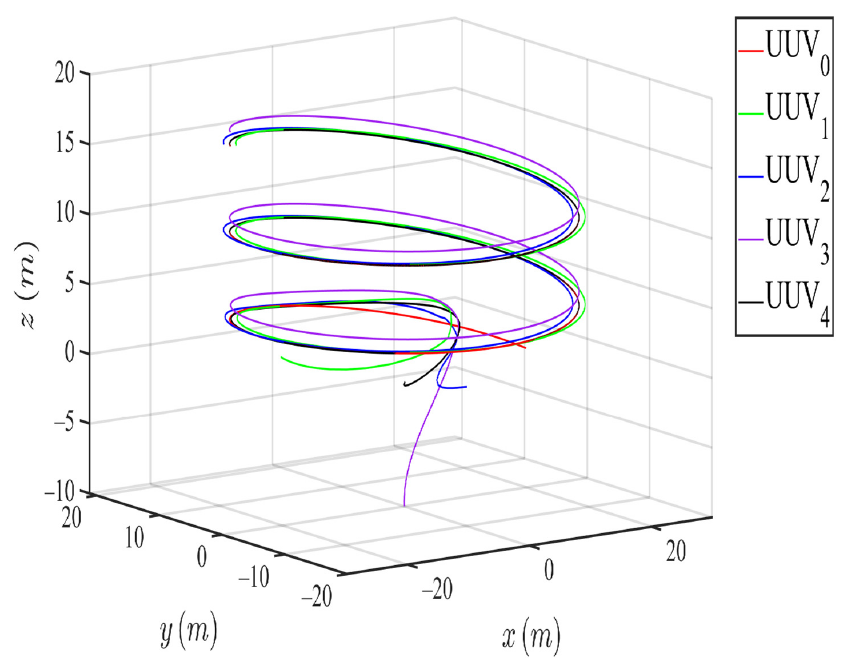
Figure 3. 3D trajectories of UUVs with disturbance observer.